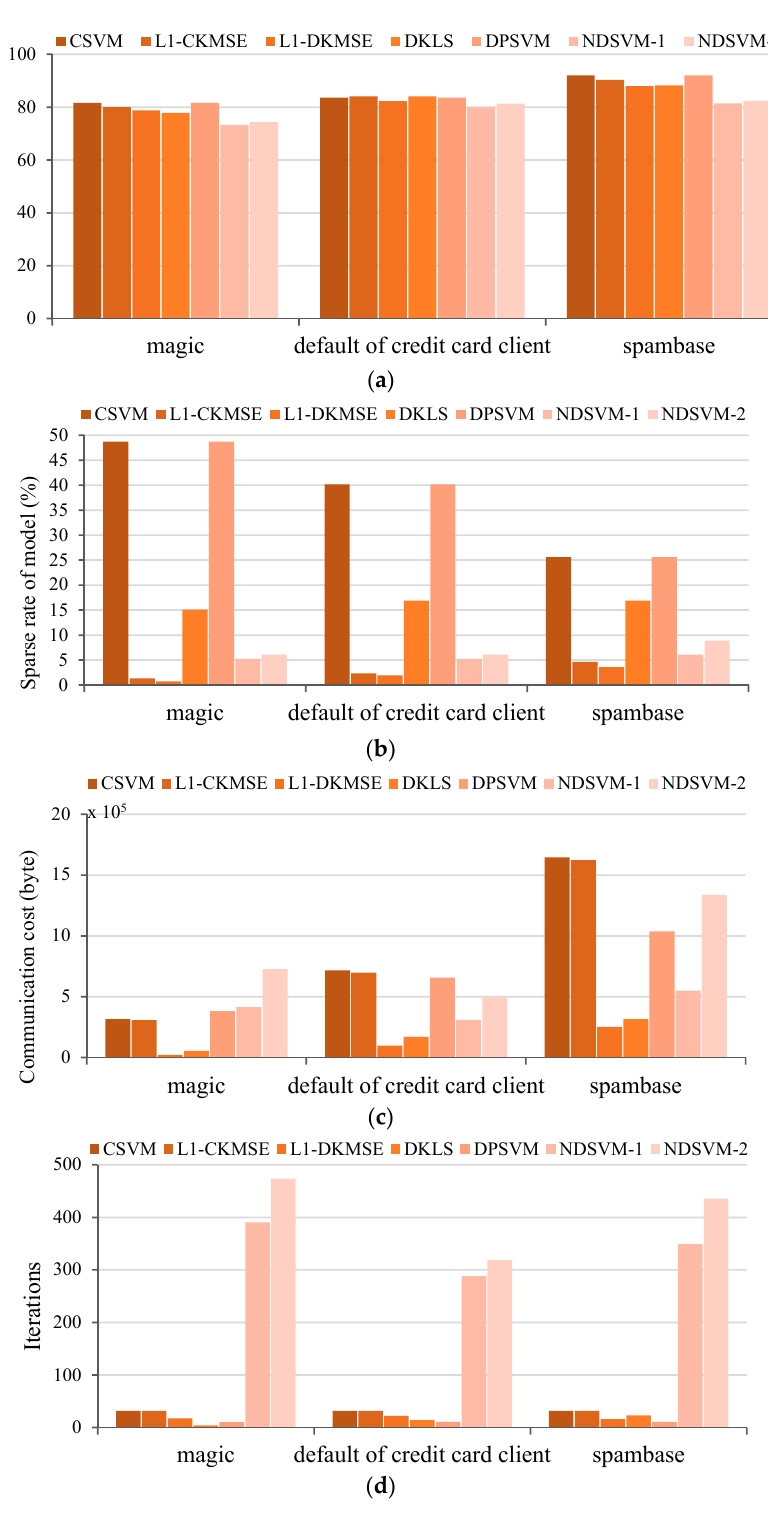
Figure 2. Performance comparisons of CSVM, L1-CKMSE, L1-DKMSE, DKLS, DPSVM and NDSVM on the UCI datasets: ( a ) prediction accuracy; ( b ) sparse rate of model; ( c ) communication cost; and ( d ) iterations.